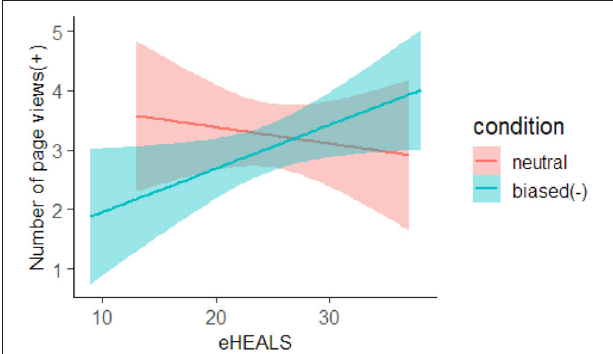
FIGURE 4 | Estimated effect of condition and eHEALS on number of page views(+). The red line represents the NEUTRAL group and the blue line represents the BIASED( − ) group. The background color indicates the confidence interval.